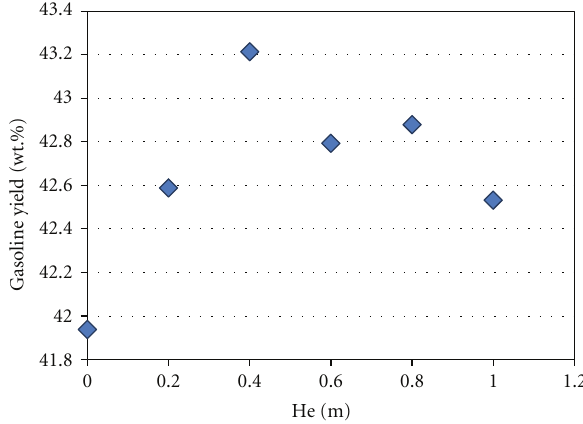
Figure 19: Gasoline yields at the riser